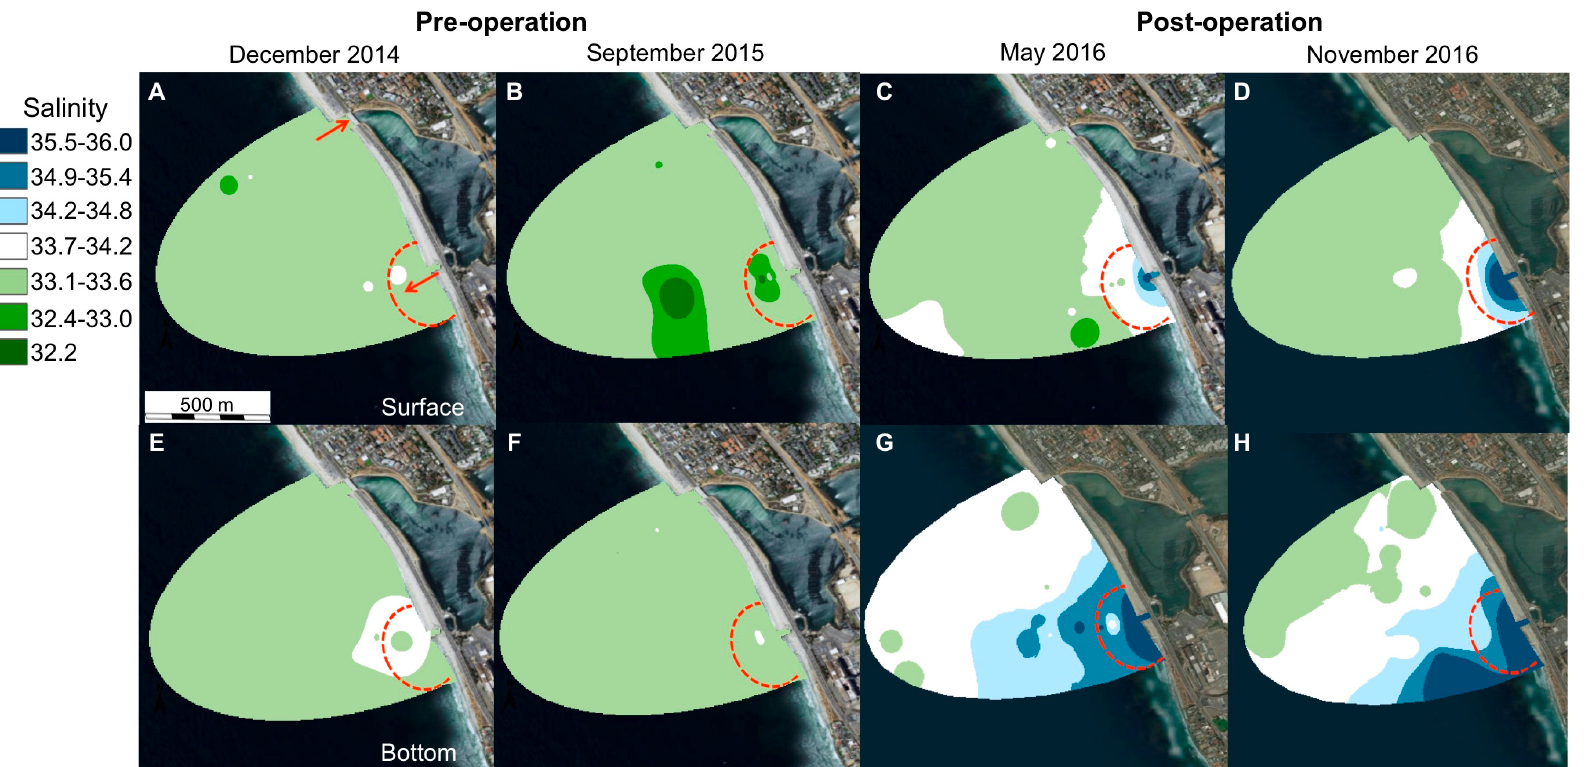
Figure 2. GIS-mapped salinity measurements for surface ( upper row ) and bottom water ( lower row ) for pre-operation ( A , B , E , F ) and post-operation ( C , D , G , H ). Arrows in ( A ) indicate the outfall location and lagoon intake area. The red semi-circle represents the 200 m distance set by California Ocean Plan (2015 Amendment to the Water Quality Control Plan).